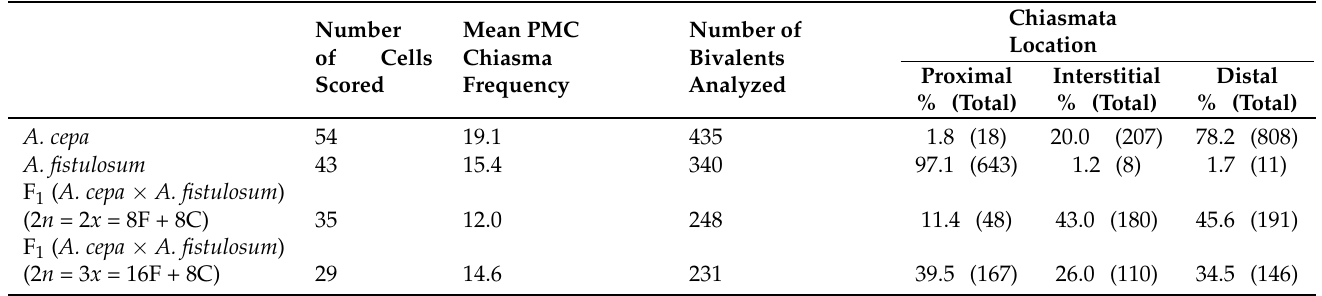
Table 1. Chiasmata frequency and distribution in A. cepa , A. fistulosum , and the F 1 diploid and triploid hybrids ( A. cepa × A. fistulosum